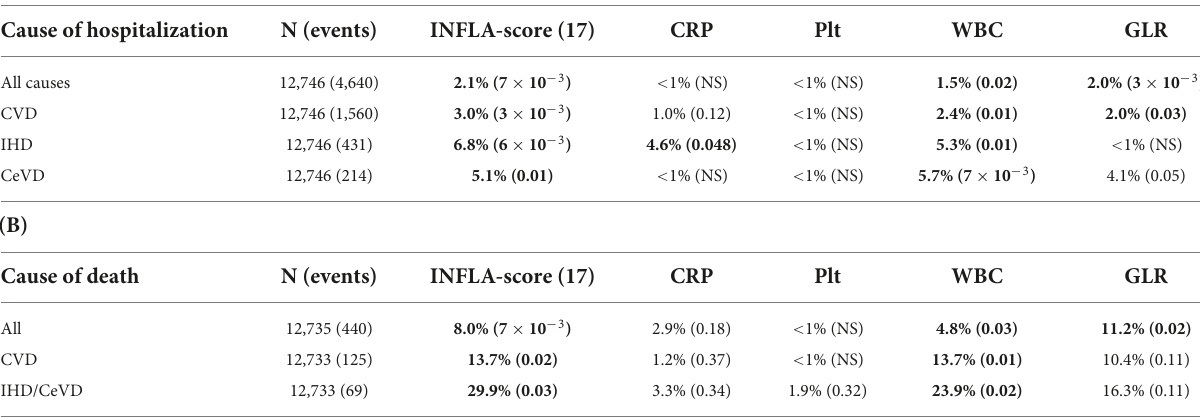
TABLE 4 Proportion of the association of depression severity with incident (A) hospitalization risk and (B) mortality explained by INFLA score component